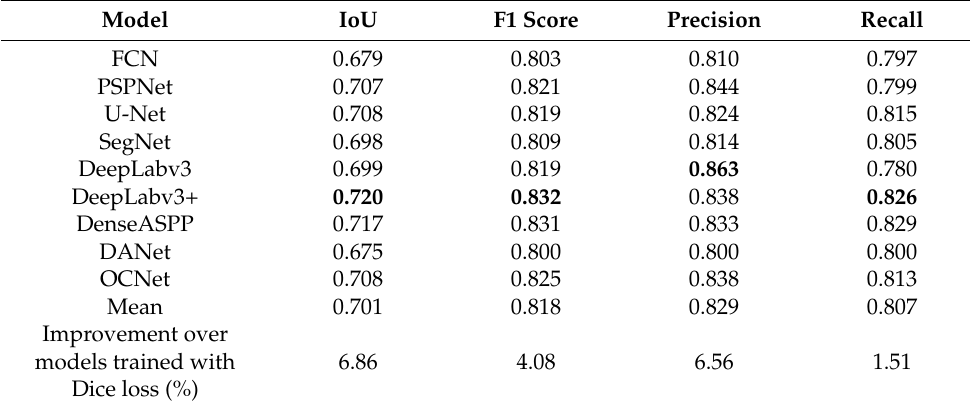
Table 3. Performance of different models using focal